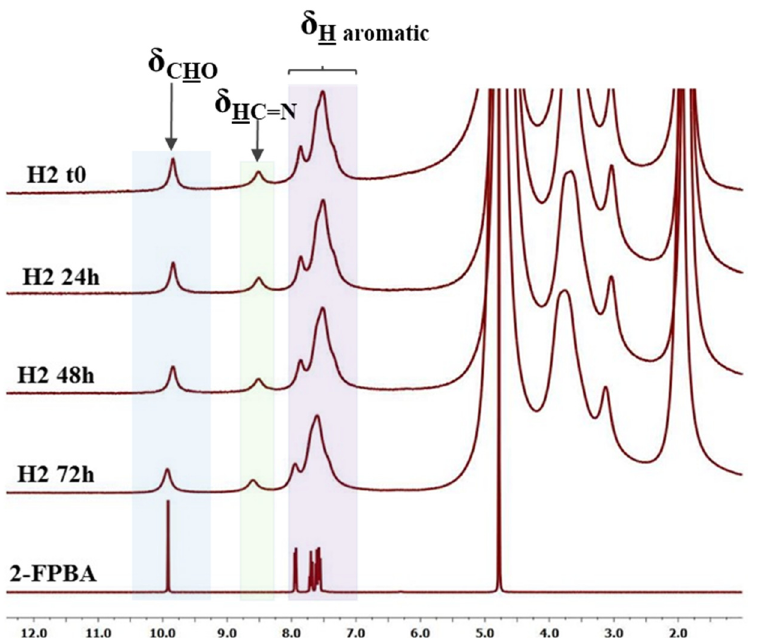
Figure 2. 1 H-NMR spectra of the hydrogel during hydrogelation, from hydrogel occurrence (t0) to 72 h, compared with the 2-FPBA reference.